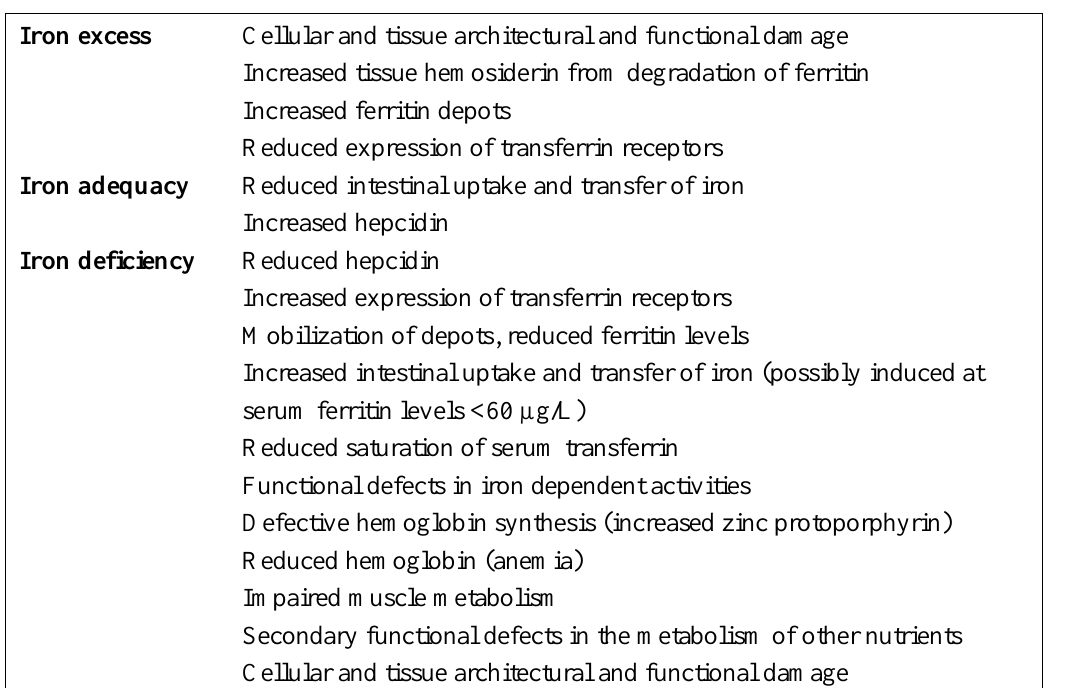
Table 5. A conceptual spectrum of iron status.